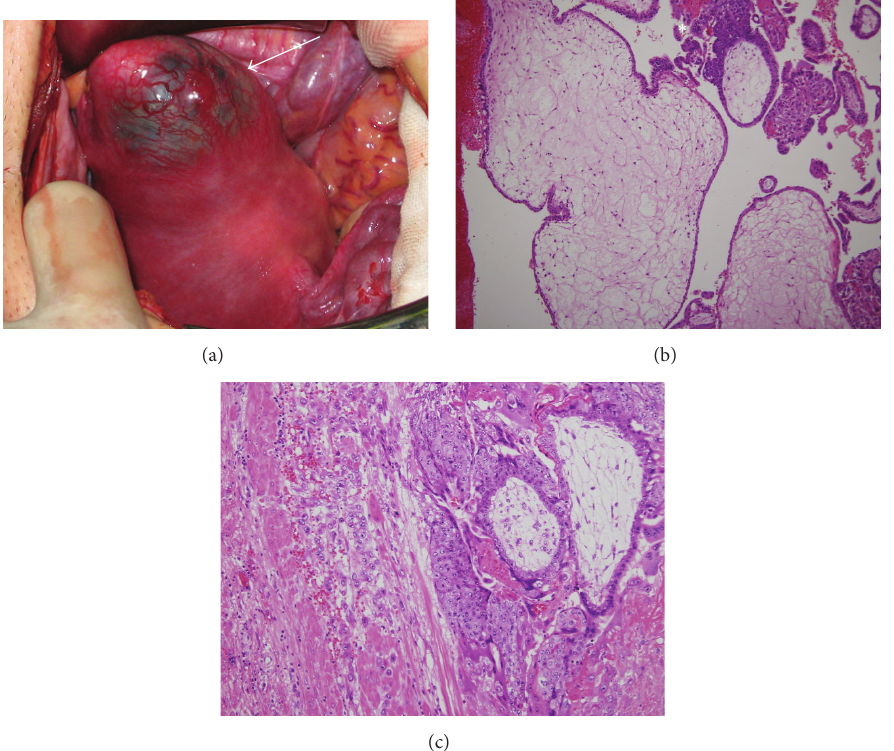
Figure 3: (a) Photograph of the uterus during laparotomy. A dark-blue mass is seen in the right cornu, with increased vascularity (arrow). (b) Enlarged hydropic villi and focal trophoblastic proliferation (asterisk) are observed. There is no cistern formation. A few proliferating stromal cells are observed but degeneration is not noted. (c) Invasion of villi and trophoblasts to the uterine myometrium. The trophoblastic proliferation is